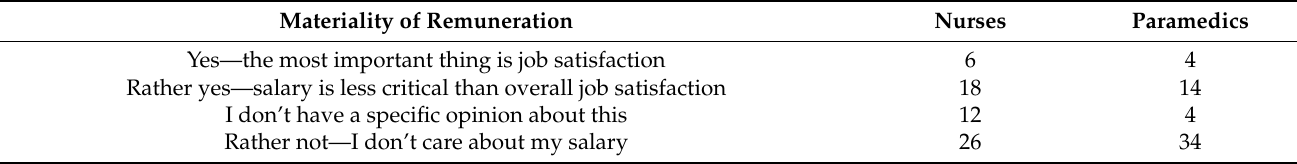
Table 5. Number of nurses and paramedics surveyed by salary relevance to